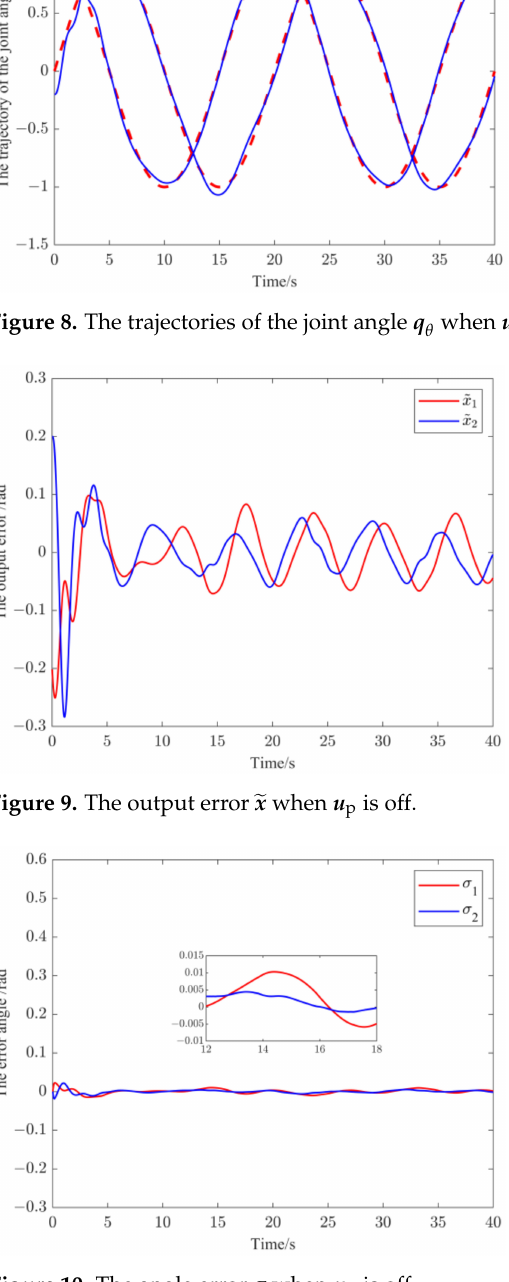
Figure 10. The angle error σ when u p is